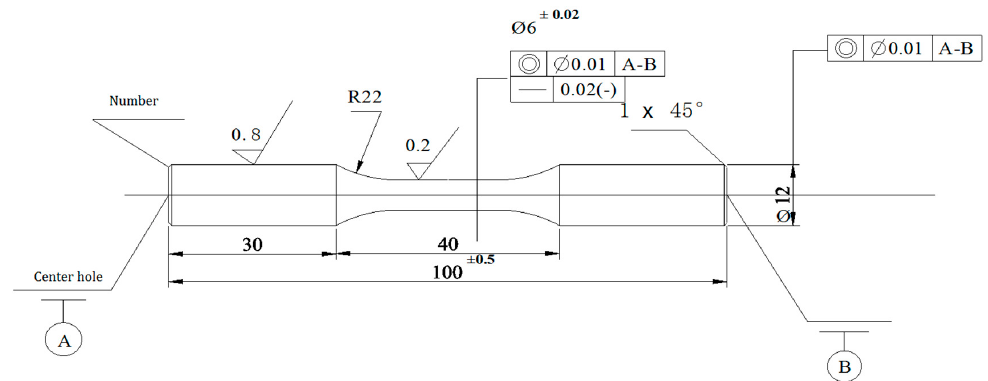
Figure 2. Schematic diagram of fatigue specimen size (unit mm).